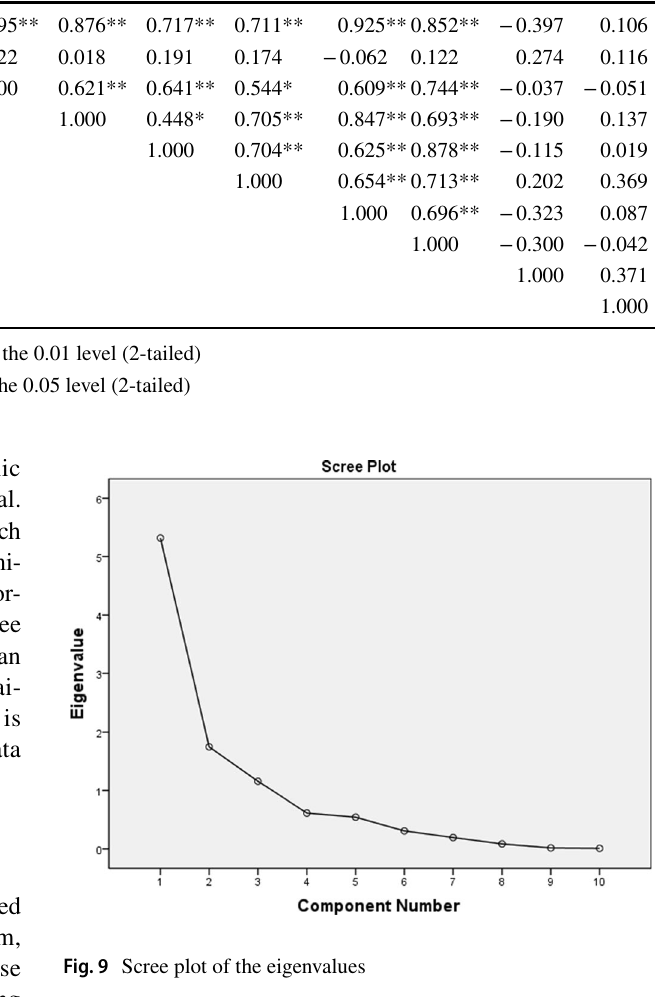
Table 2 Correlation matrix of the physical and chemical parameters of the water samples